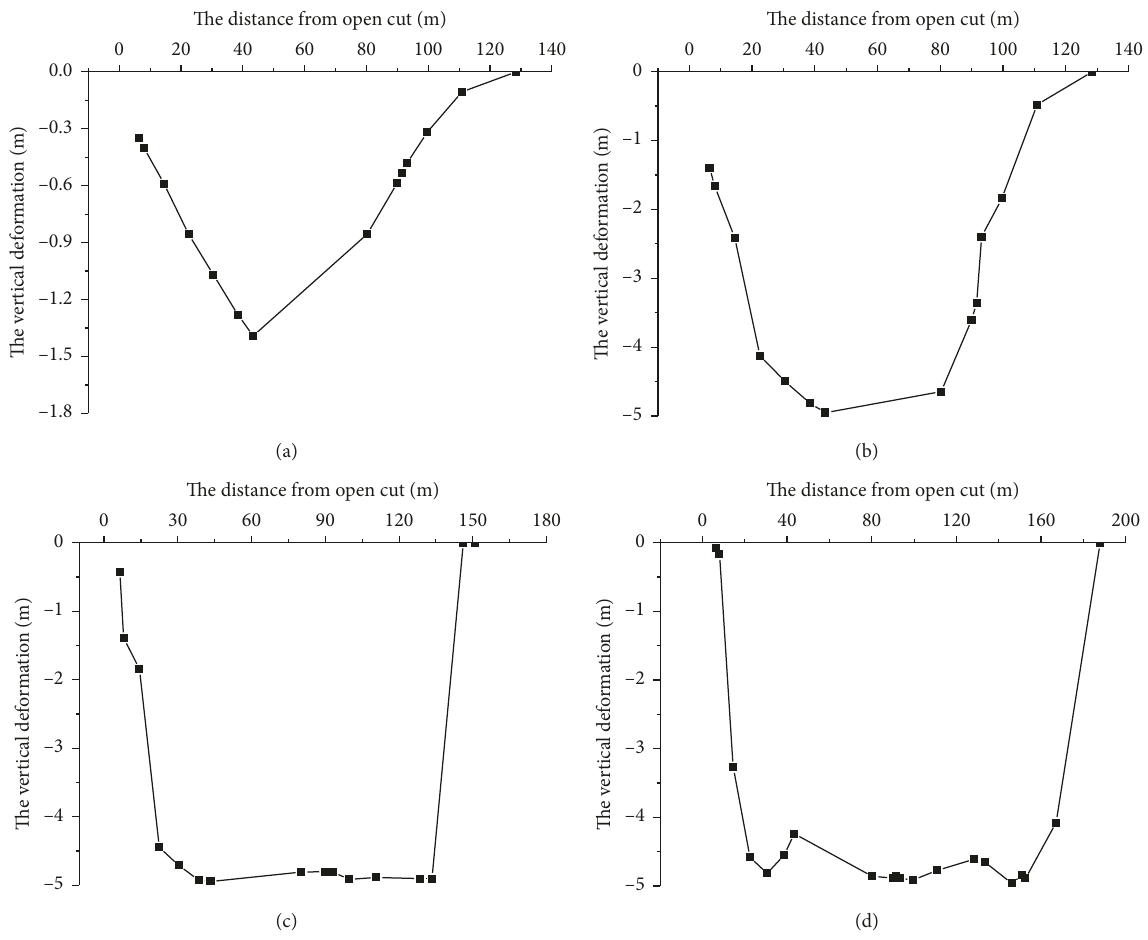
Figure 13: The vertical deformation of the test points during excavation. The coal stratum is excavated to (a) 120 m, (b) 130m, (c) 165m, and (d)